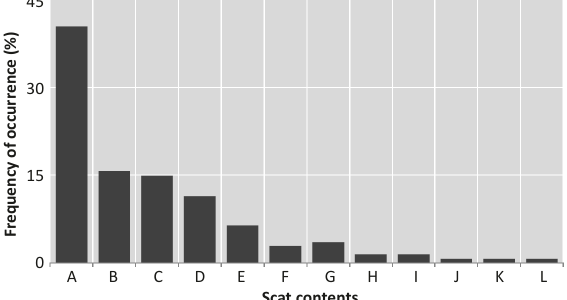
Figure 2. Overall visualization of the scat content of the Golden Jackal in Gir National Park and Sancturay,India. [A - Plant material ( Zizyphus spp . and Caparis spp.); B - Buffalo; C - Chital; D - Indian Hare; E - Sambar; F - Rodents; G - Cow; H - Hanuman Langur; I - Bluebull; J - Peafowl; K - Plastic; L - Rubber]